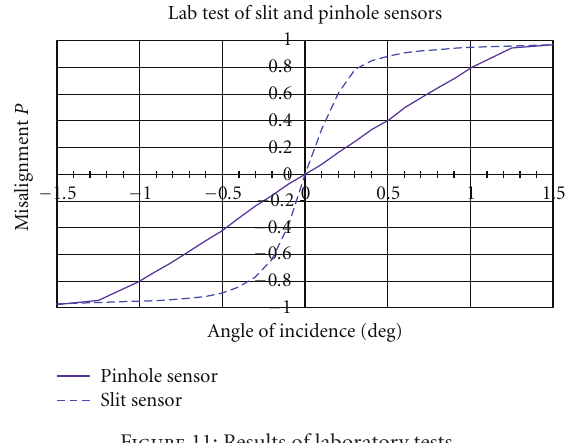
Figure 11: Results of laboratory tests.